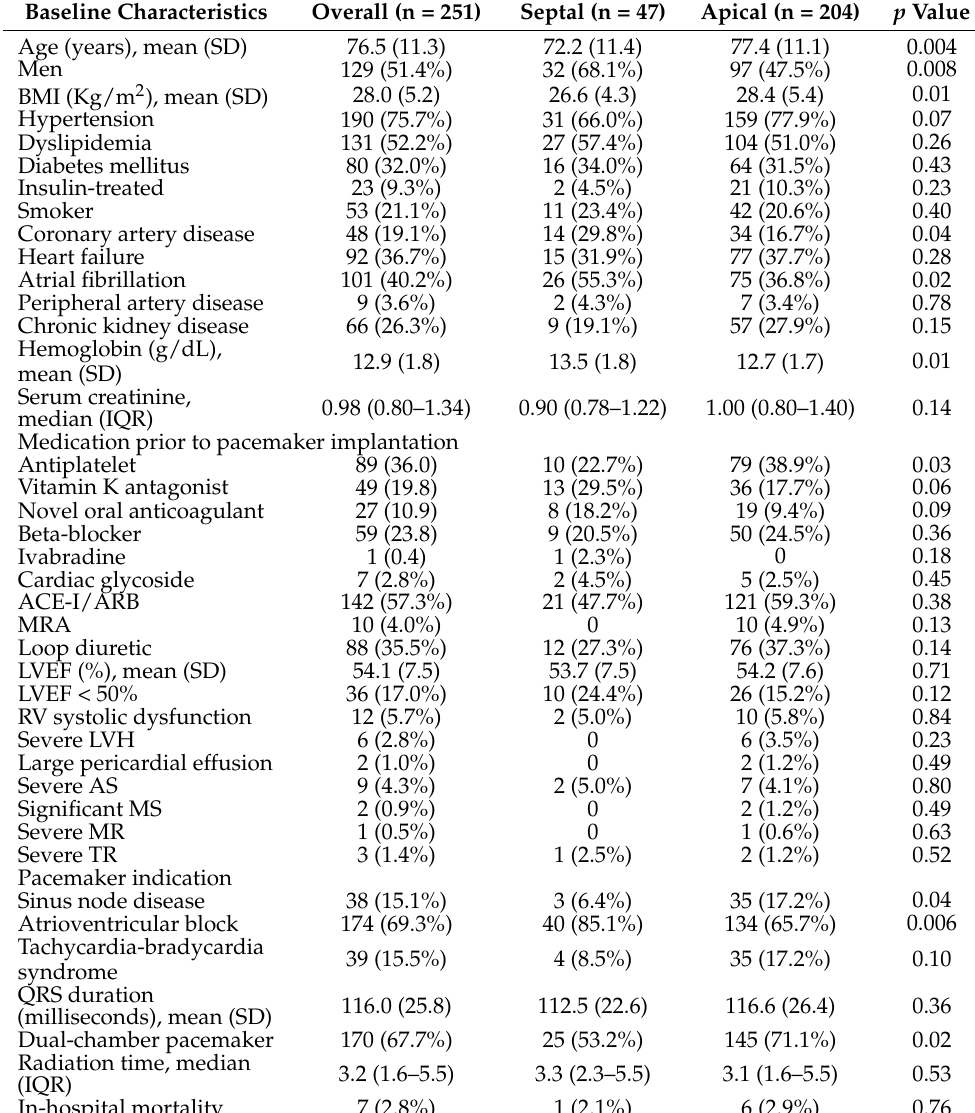
Table 1. Baseline characteristics of studied population, by the location of the right ventricular pacing